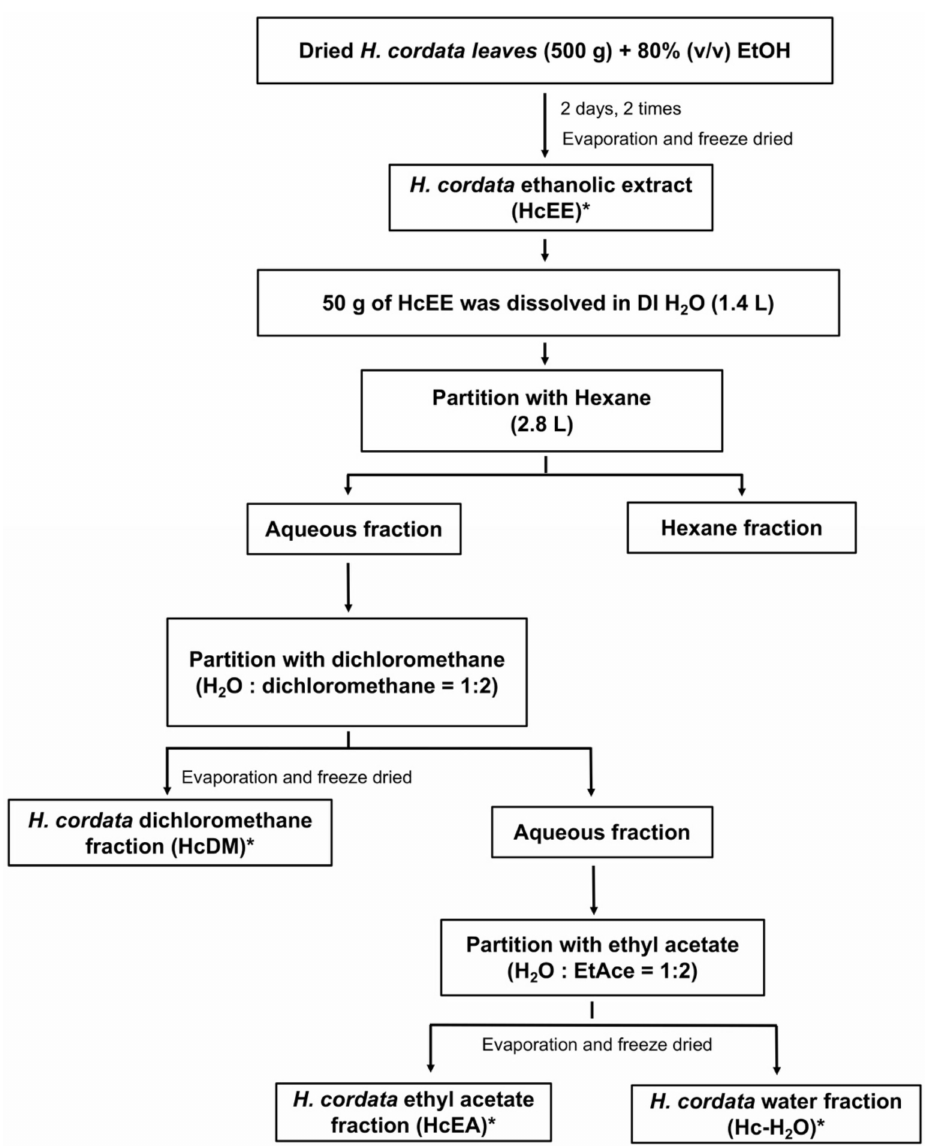
Figure 7. Preparation of H. cordata Thunb. extracts and solvent-partitioned extraction technique. The diagram represents the flow chart of ethanolic extraction and the solvent-partition method to obtain the ethanolic extract and the concentrated fractions of H. cordata , including, H. cordata ethanolic extract (HcEE), H. cordata dichloromethane fraction (HcDM), H. cordata ethyl acetate fraction (HcEA), and H. cordata water fraction (Hc-H 2 O). EtOH: ethanol, DI H 2 O: deionized water, EtAce: ethyl acetate. * H. cordata extracts that were used in this